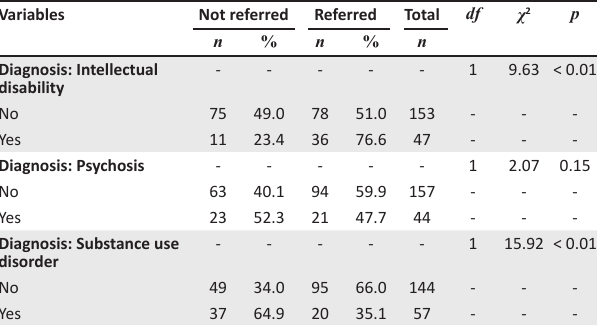
TABLE 3: Clinical diagnosis comparison between group referred to Fort Napier Hospital and group not referred. Variables